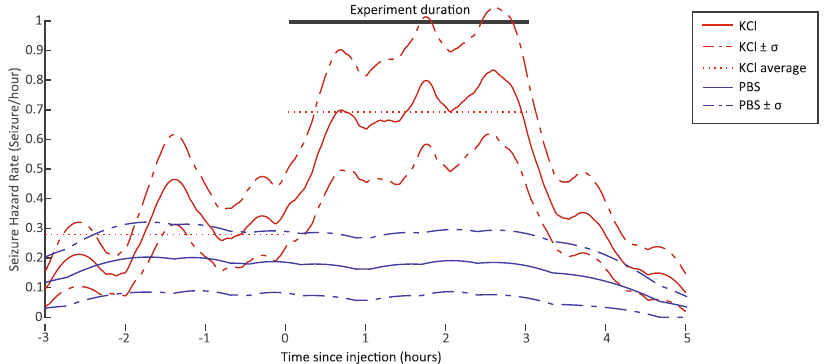
Figure 5. Time-dependent seizure hazard rates. The KCl solution injection significantly increases the seizure hazard rate immediately after the first injection was administered (time 0), more than doubling the risk of seizures during the experiment. In contrast, PBS injections had no effect on seizure risk. Dotted lines indicate the average risk across all animals before and during the